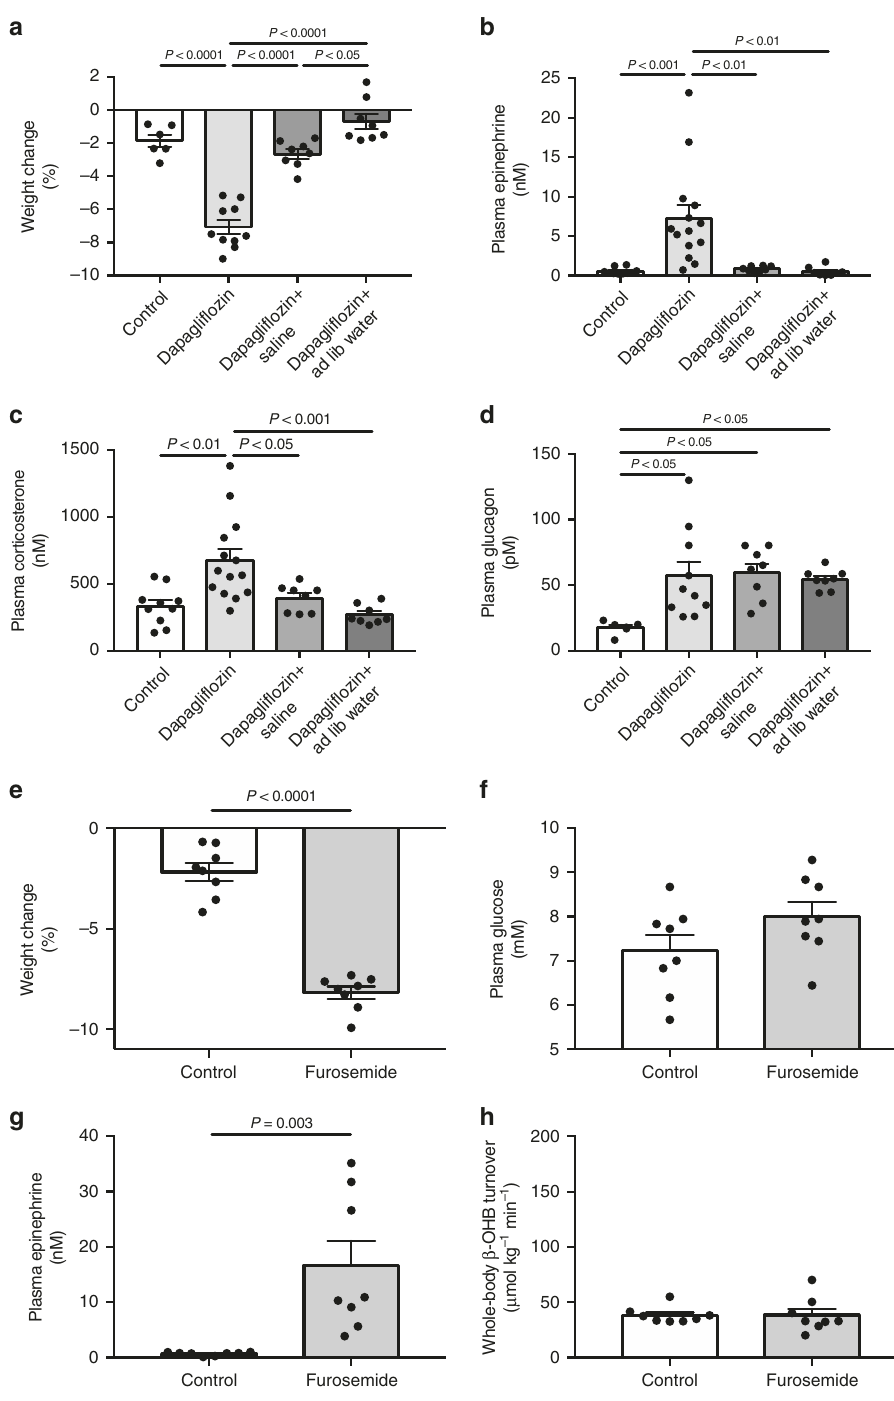
Fig. 2 Dapagli fl ozin-induced increases in hepatic ketogenesis and hepatic glucose production are caused by extracellular volume depletion. a Weight change from baseline (time of injection) measured six hours after treatment. b – d Plasma epinephrine, corticosterone, and glucagon concentrations. Data are the mean ± S.E.M., with comparisons by ANOVA with Bonferroni ’ s multiple comparisons test. e , f Weight change and plasma glucose concentrations six hours after treatment with furosemide. g Plasma epinephrine. h Whole-body β -OHB turnover. In panels e – h , comparisons were performed using the 2- tailed unpaired Student ’ s t -test. Data are the mean ±